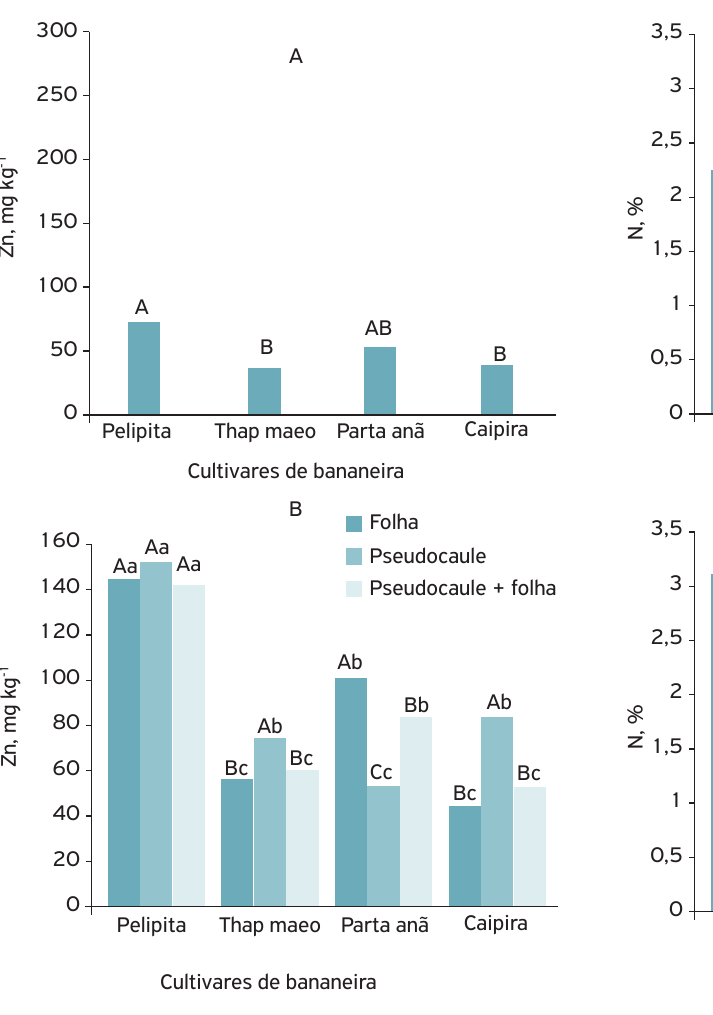
Figura 6. Teores de N,%, presente no substrato à base de resíduos de bananeira (pseudocaule, folha e pseudocaule + folha) de quatro cultivares de bananeira (Thap maeo, Prata anã, Pelipita e Caipira) antes (A) e após 49 dias (B) de colonização pela linhagem 09/100 de Pleurotus ostreatus . Letras maiúsculas comparam médias dentro de um mesmo cultivar de bananeira; letras minúsculas comparam médias dentro de cada tipo de resíduo. Médias seguidas de letras iguais não diferem entre si (Tukey, 5%) (Média de duas